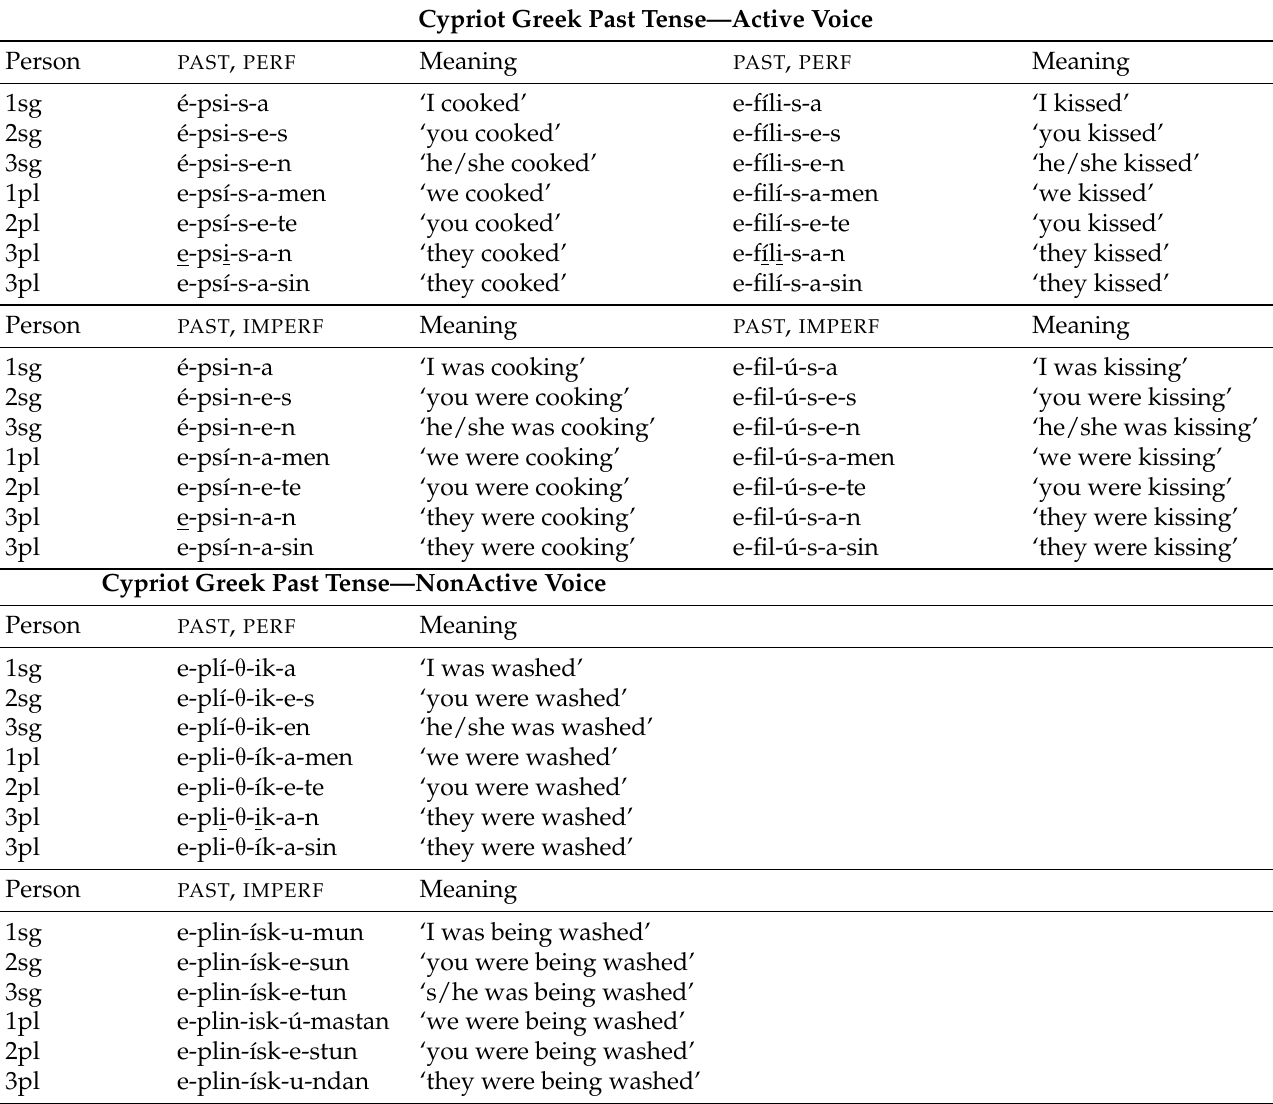
Table 1. Cypriot Greek verbal morphology in Active and